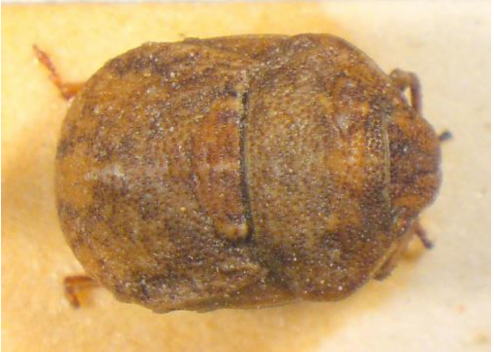
Figure 18. Tarisa pallescens (Collector S. Drosopoulos, Kryovryssi, 30.V.1982, posited in S. Drosopoulos historical collection. Photo A. Tsagkarakis, 12.III.2021).